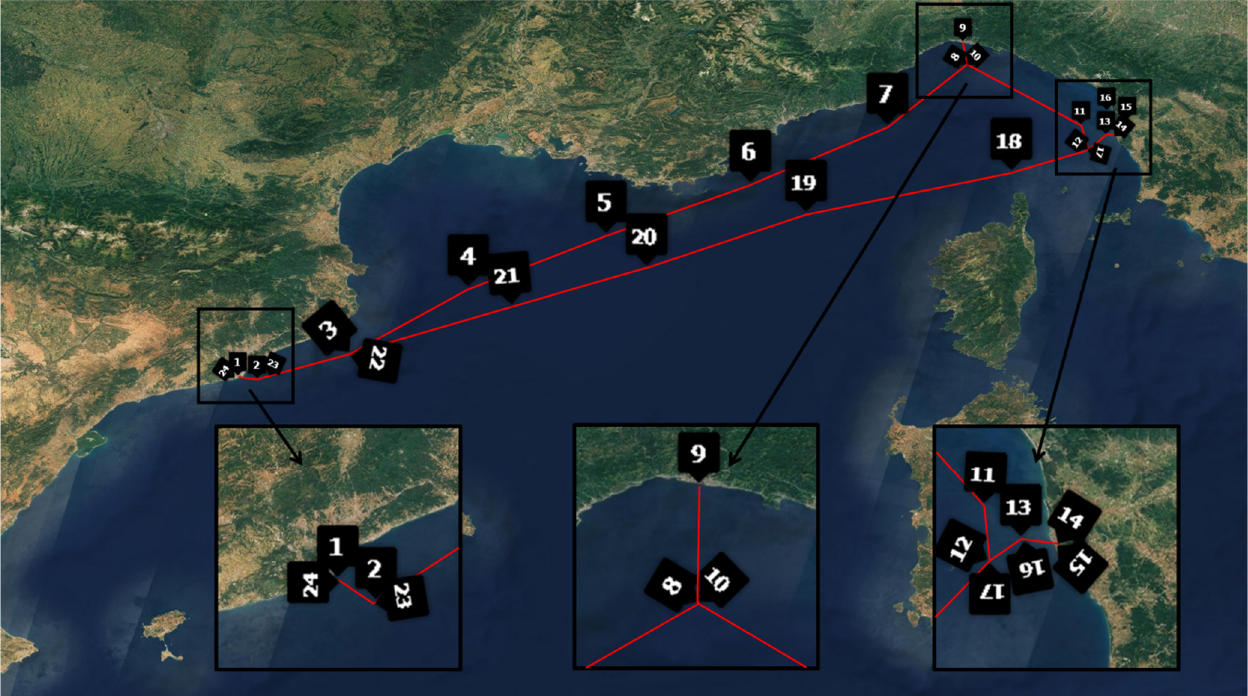
Figure 2. Route selected for calculation (Barcelona–Genoa–Livorno–Barcelona). The numbers in the Figure correspond with each analyzed route point, described in Annex A. Source: Own elaboration.